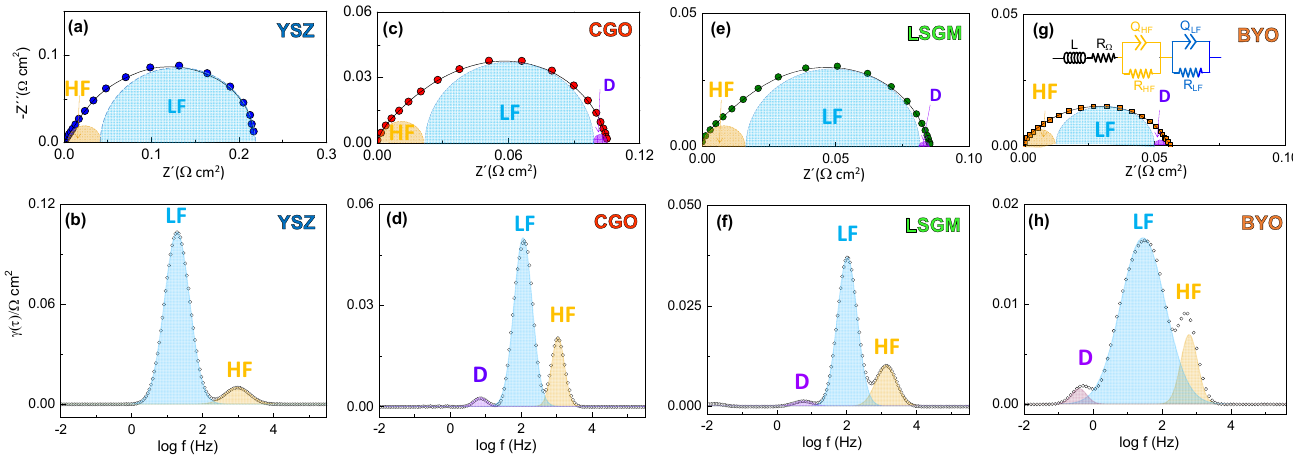
Figure 3. Impedance spectra (top) and DRT analysis (bottom) at 700 °C of the LSCF electrode deposited on ( a , b ) YSZ, ( c , d ) CGO, ( e , f ) LSGM and ( g , h ) BYO. The inset of ( g ) shows the equivalent circuit used to fitting the data.